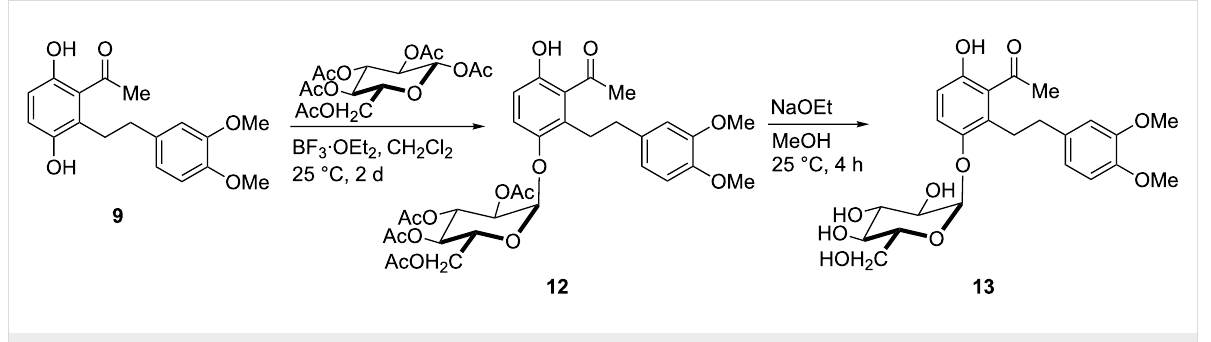
Scheme 4: Synthesis of glycoside 12 and deprotected epi -scorzodihydrostilbene D ( 13 ). Yields of isolated products: 12 : 14%; 13 :